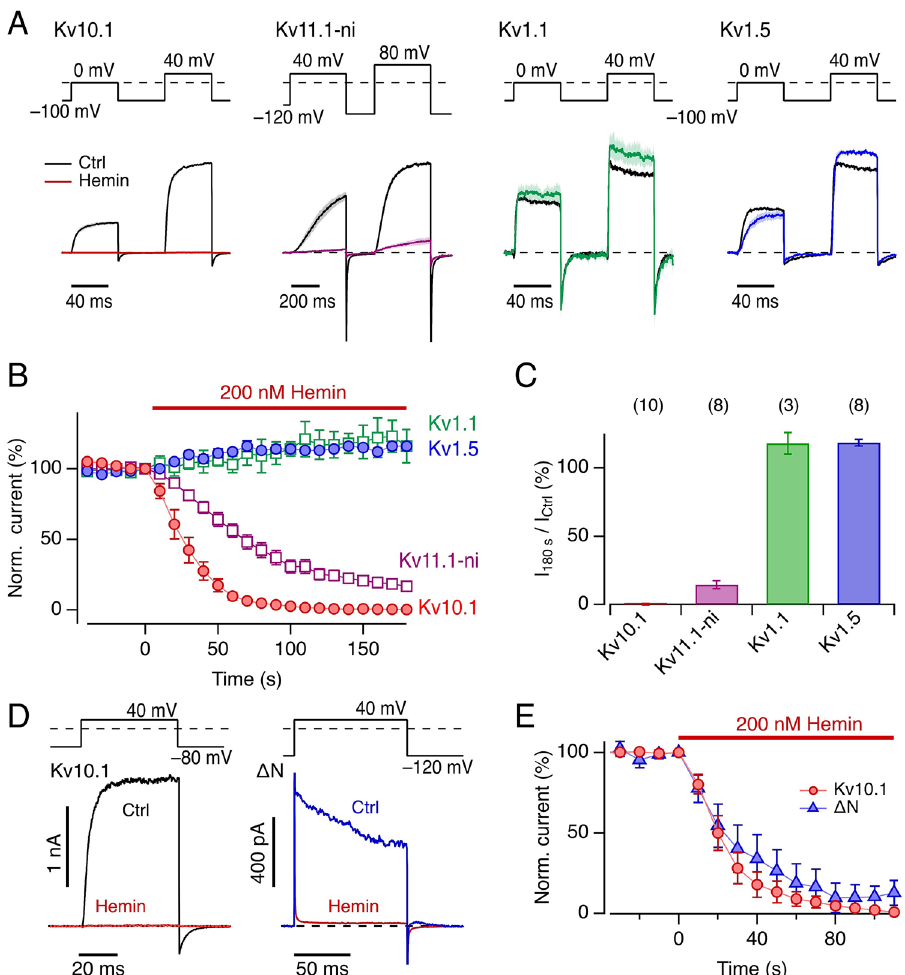
Figure 3. Effect of intracellular hemin on voltage-gated K + channels. ( A ) Averaged current responses, normalized to the maximal control current at 40 mV (80 mV for Kv11.1-ni), of the indicated channel types recorded from inside-out patches of Xenopus oocytes before (black) and 180 s after (color) application of 200 nM hemin. Depolarization steps were applied to 0 and 40 mV for Kv10.1, Kv1.1, and Kv1.5 channels, and to 40 and 80 mV for Kv11.1-ni. Thick traces are means; shading indicates sem; for n see panel ( C ). ( B ) Normalized, mean maximal currents at 40 mV (80 mV for Kv11.1-ni) as a function of time after application of 200 nM hemin at time zero. Straight lines connect data points for clarity. ( C ) Averaged relative current remaining 180 s after application of 200 nM hemin for the indicated channel types. Data are mean ± sem, the numbers of independent experiments are indicated in parentheses. ( D ) Representative current traces recorded from inside-out Xenopus oocyte patches with Kv10.1 wild-type channels (left) at 40 mV before (black) and 150 s after application of 200 nM hemin. Right: Current traces for the N-terminal deletion mutant (∆N) before (blue) and 90 s after application of 200 nM hemin (red). Holding potential for Kv10.1 was − 80 mV and for Kv10.1∆N − 120 mV; the latter traces are shown without p/n leak subtraction because of high channel activity in the leak voltage range. ( E ) Time course of current decrease after application of 200 nM hemin for the indicated channel types: Kv10.1 ( n = 8) and Kv10.1∆N ( n =